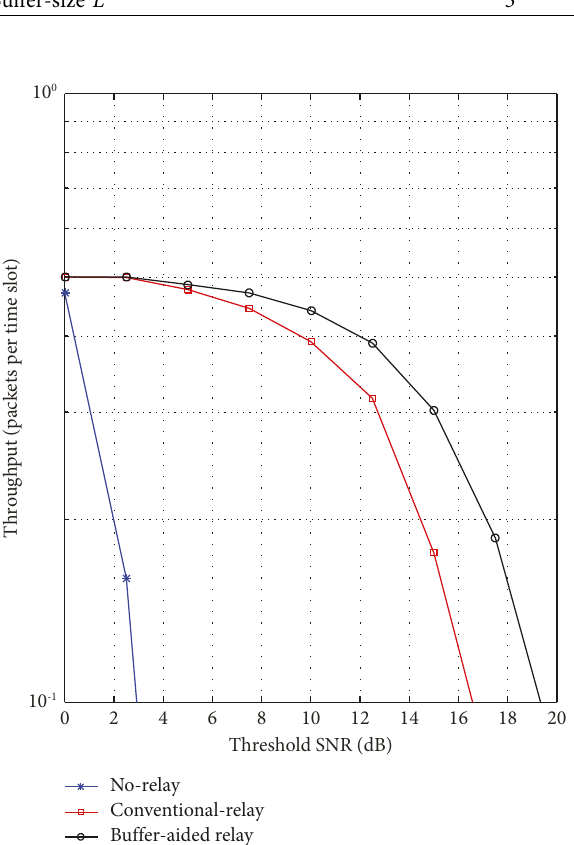
Figure 2: Outage probability comparison between the available solutions and the proposed solution.